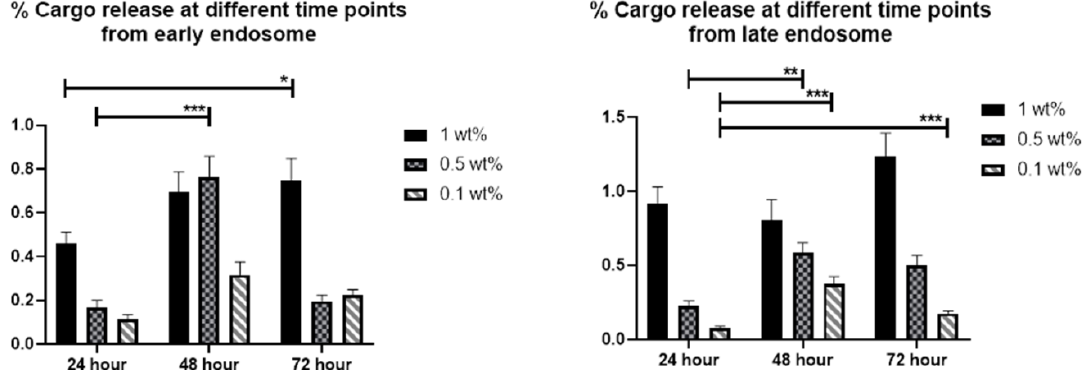
Figure 6. Relative amount of non-localized cargo signal with the endosomal marker signal over time, representing the effect of DiD loading amount on the release from early/late endosomes (* p ≤ 0.05; ** p ≤ 0.01; *** p ≤ 0.001).